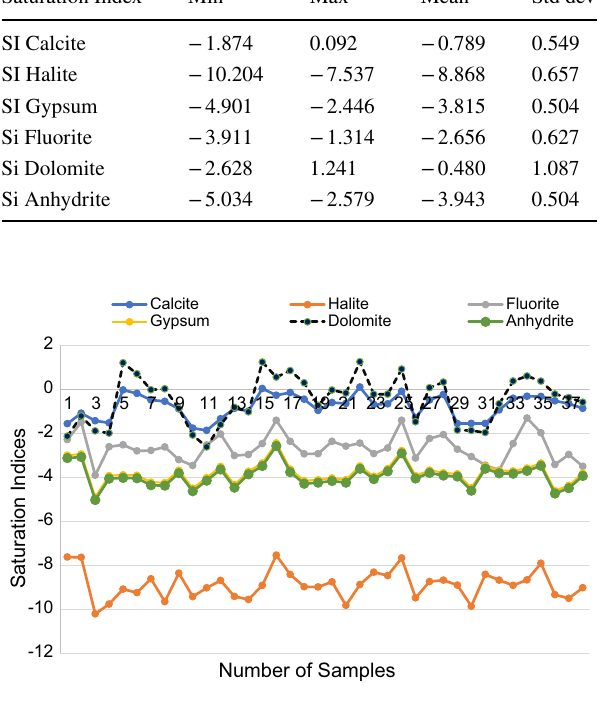
Fig. 12 Mineral saturation index of groundwater in the study